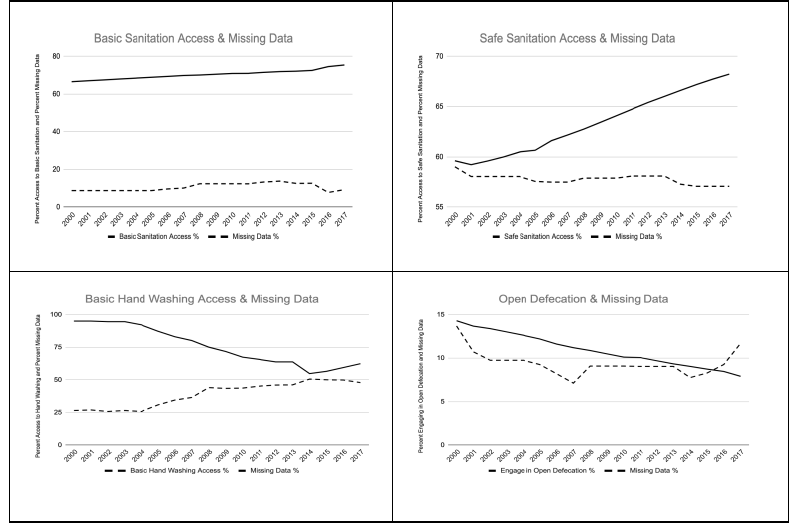
Figure 1. Sanitation Averages and Missing Data.